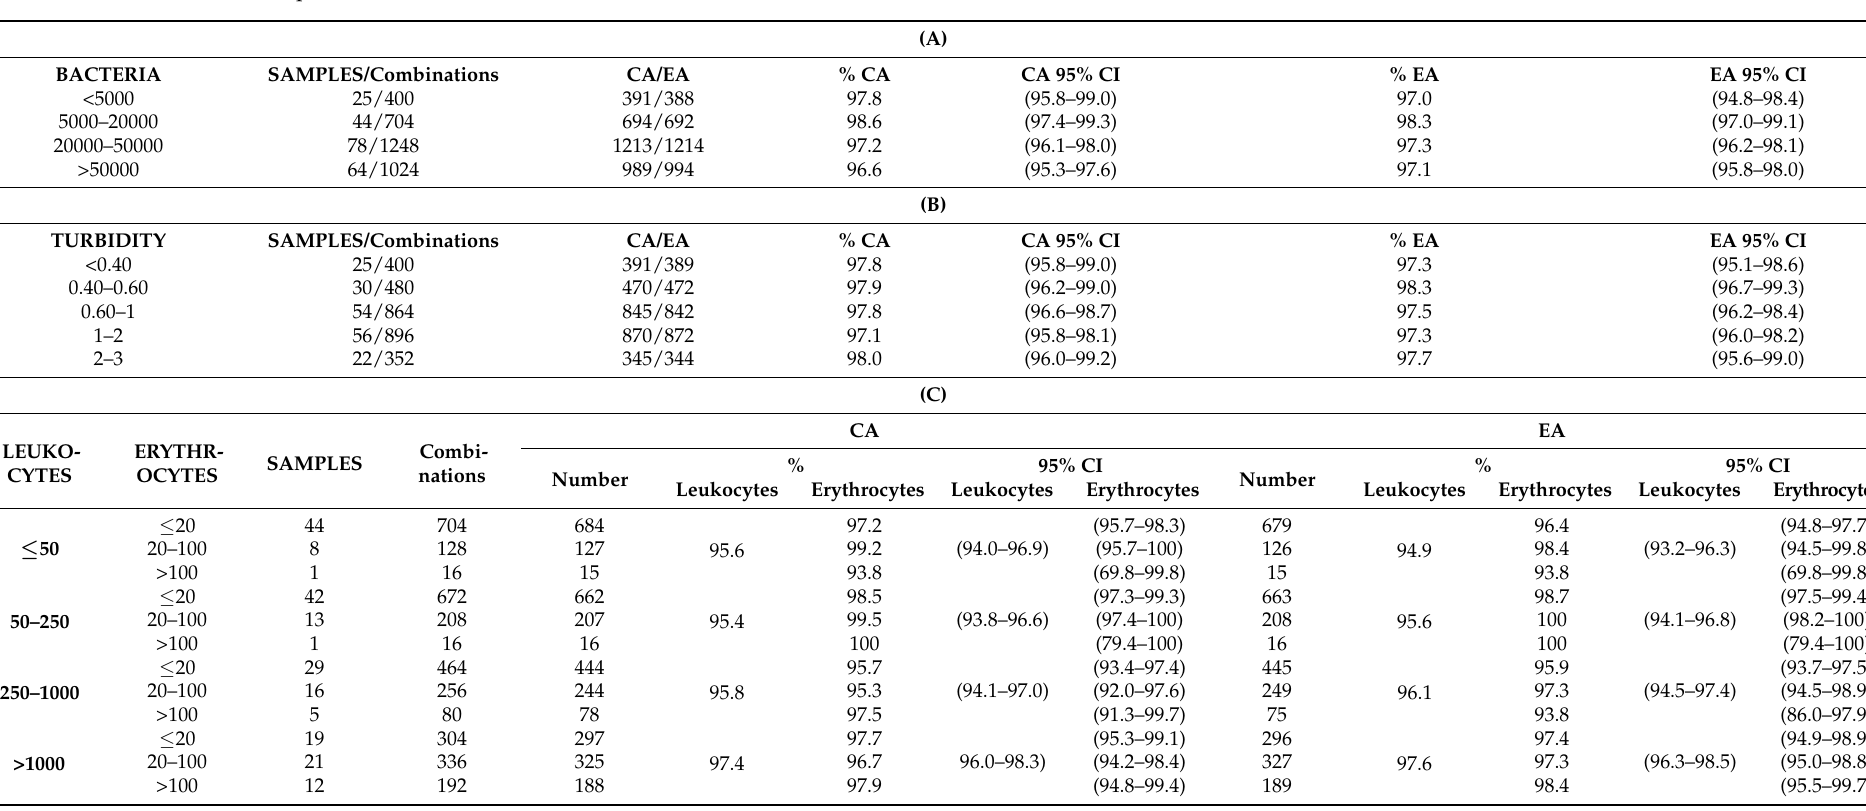
Table 2. Concordances for (A) bacteria, (B) turbidity, and (C) leukocytes and erythrocytes. The combinations represent the number of combinations of sam-